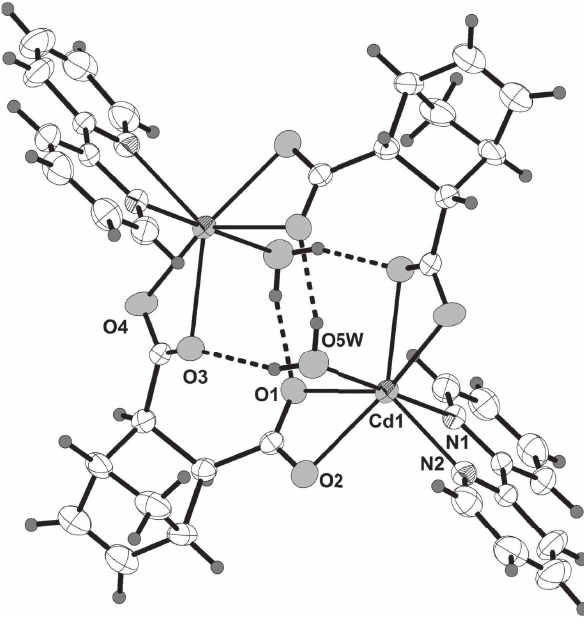
Table 1: Data collection and handling.